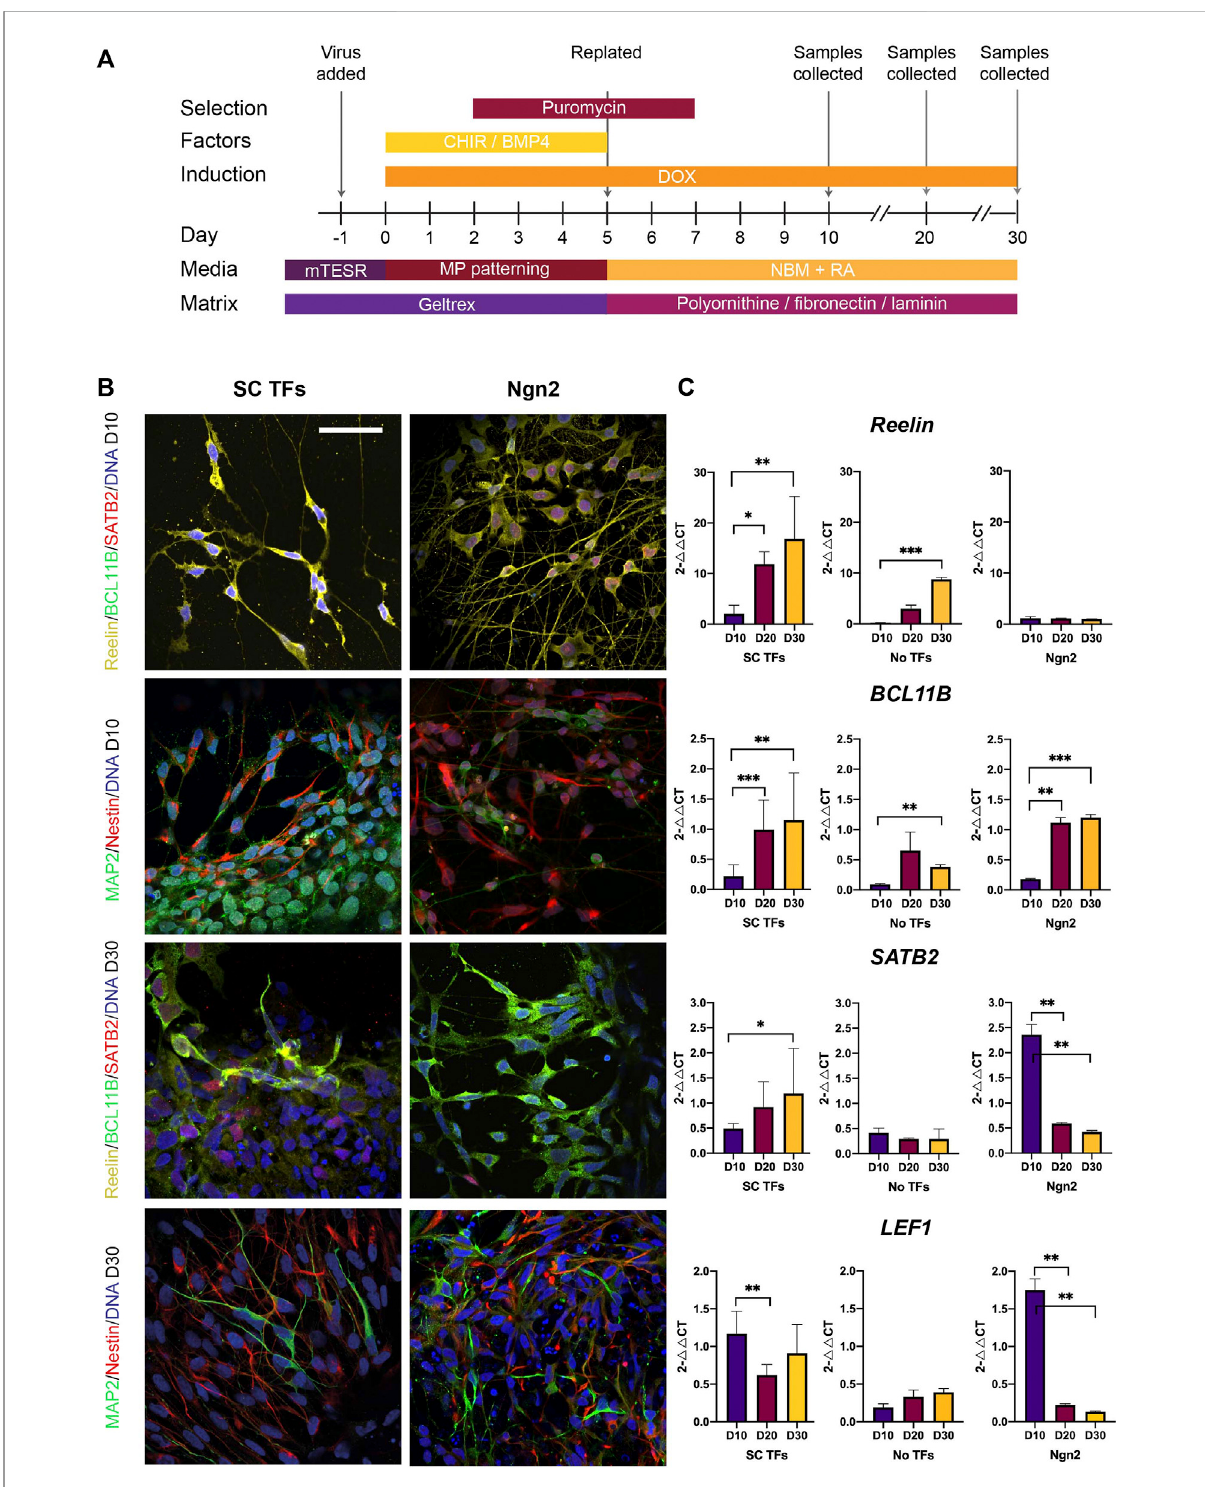
FIGURE 5 Directreprogrammingofinducedpluripotentstemcells(iPSCs)resultsintheproductionofstellatecell(SC)-likecells. (A) Schematicdiagramof the protocol used for directly reprogramming iPSCs into stellate cells using the selected transcription factors (TFs), including timing of media and matrix change, transfection, gene induction (using DOX), addition of patterning factors (CHIR 99021 and BMP4), and collection of samples. Abbreviations: Doxycycline (DOX); pluripotent stem cell media (mTESR); neurobasal medium with medial pallium patterning factors (MP patterning); neurobasal medium for maintenance of neurons (NBM). (B) Using immunocytochemistry, iPSCs transduced with the stellate